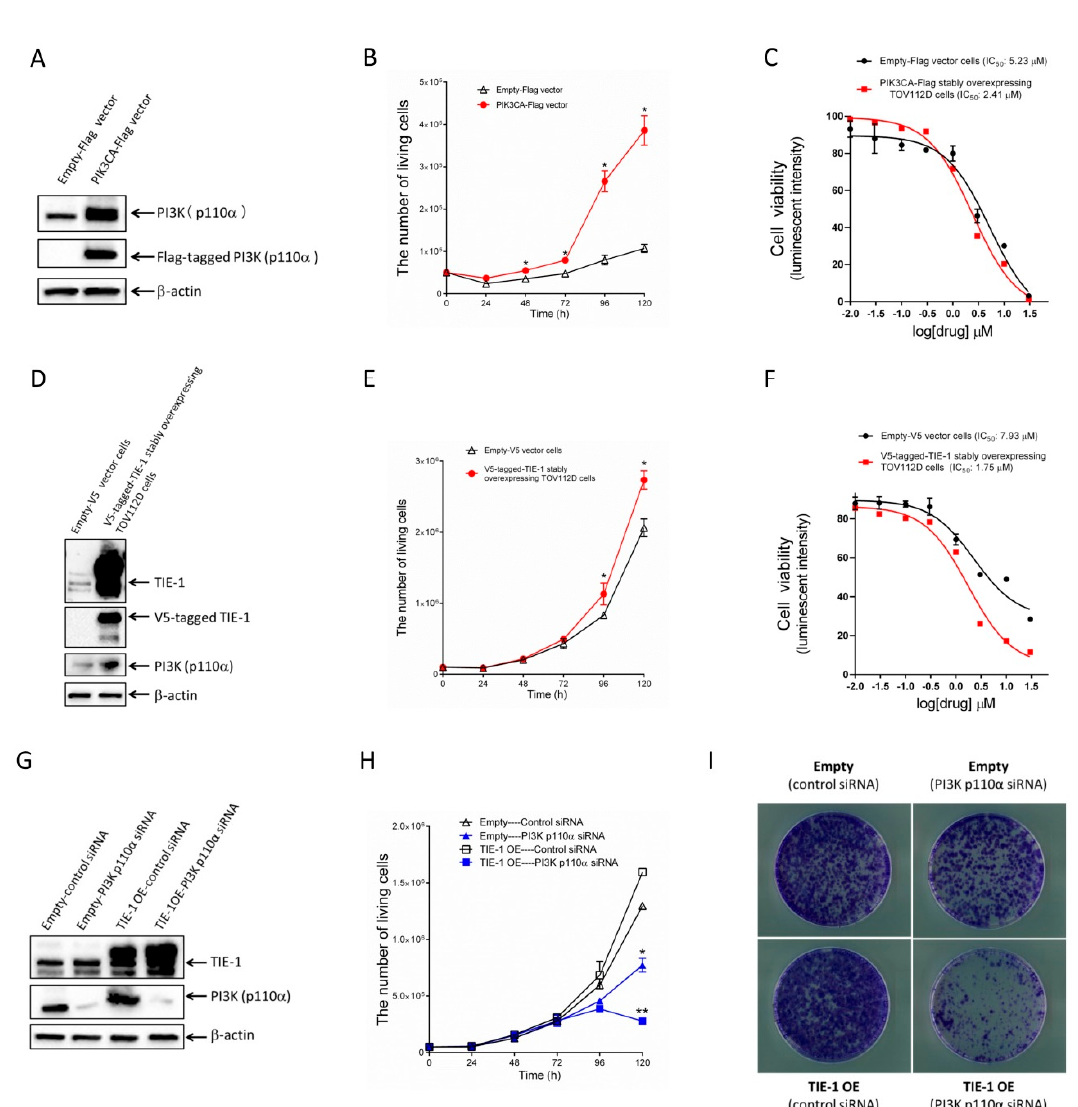
Figure 4. Increased TIE-1 expression induces TIE-1 / PI3K-mediated cell growth in low-PI3K-expressing TOV112D ovarian-cancer cells. ( A ) TOV112D ovarian-cancer cells transfected with empty vector or PI3K–Flag vector for 72 h. Extracted cellular proteins subjected to immunoblot analysis with antibodies against PI3K p110 α , Flag, and β -actin. Equal amounts of proteins loaded in each lane. Three independent experiments were performed, and representative images are shown. ( B ) TOV112D ovarian-cancer cells transfected with empty vector or PI3K–Flag vector for up to 120 h. Living cells were counted. Values shown as mean ± SD ( n = 3); *, p < 0.05 compared with empty-vector group. ( C ) Empty Flag vector cells and TOV112D cells stably overexpressing Flag-tagged PI3K were treated with 0.01, 0.03, 0.1, 0.3, 1, 3, 10, or 30 µ M of PI3K inhibitor GDC-0941 (Pictilisib). Cell viability determined using CellTiter-Glo luminescent cell-viability assay according to manufacturer’s protocol. Data shown (mean ± SD, n = 3) are percentages relative to cells treated with negative control. ( D ) Extracted cellular proteins from empty V5 vector cells and V5-tagged TIE-1 stably overexpressing TOV112D cells subjected to immunoblot analysis with antibodies against TIE-1, V5, PI3K p110 α , and β -actin. Equal amounts of protein loaded in each lane. Three independent experiments were performed, and representative images shown. ( E ) V5-tagged TIE-1 stably overexpressing TOV112D cells or empty-vector cells seeded in six-well plates and incubated for up to 120 h. Living cells were counted. Values shown as mean ± SD ( n = 3); *, p < 0.05 compared with empty-vector group. ( F ) Empty V5 vector cells and